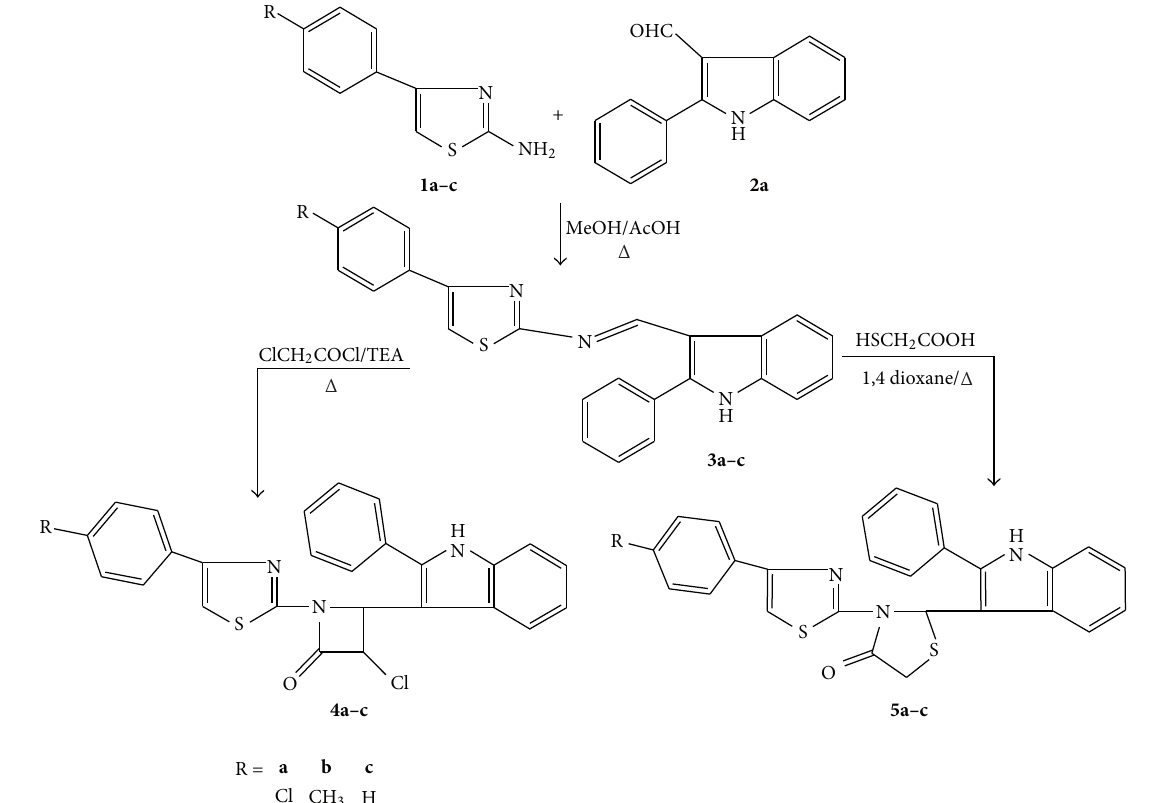
S 1: Schematic representation for the synthesis of indole derivatives ( 3–5 ).